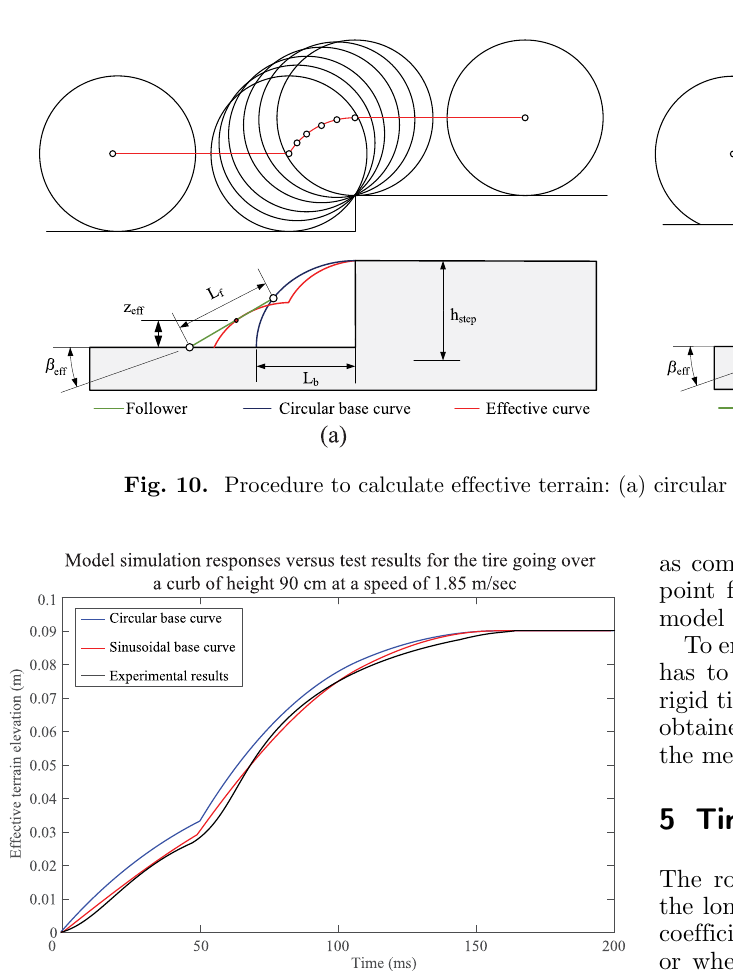
Fig. 11. Comparison of terrain enveloping models with test